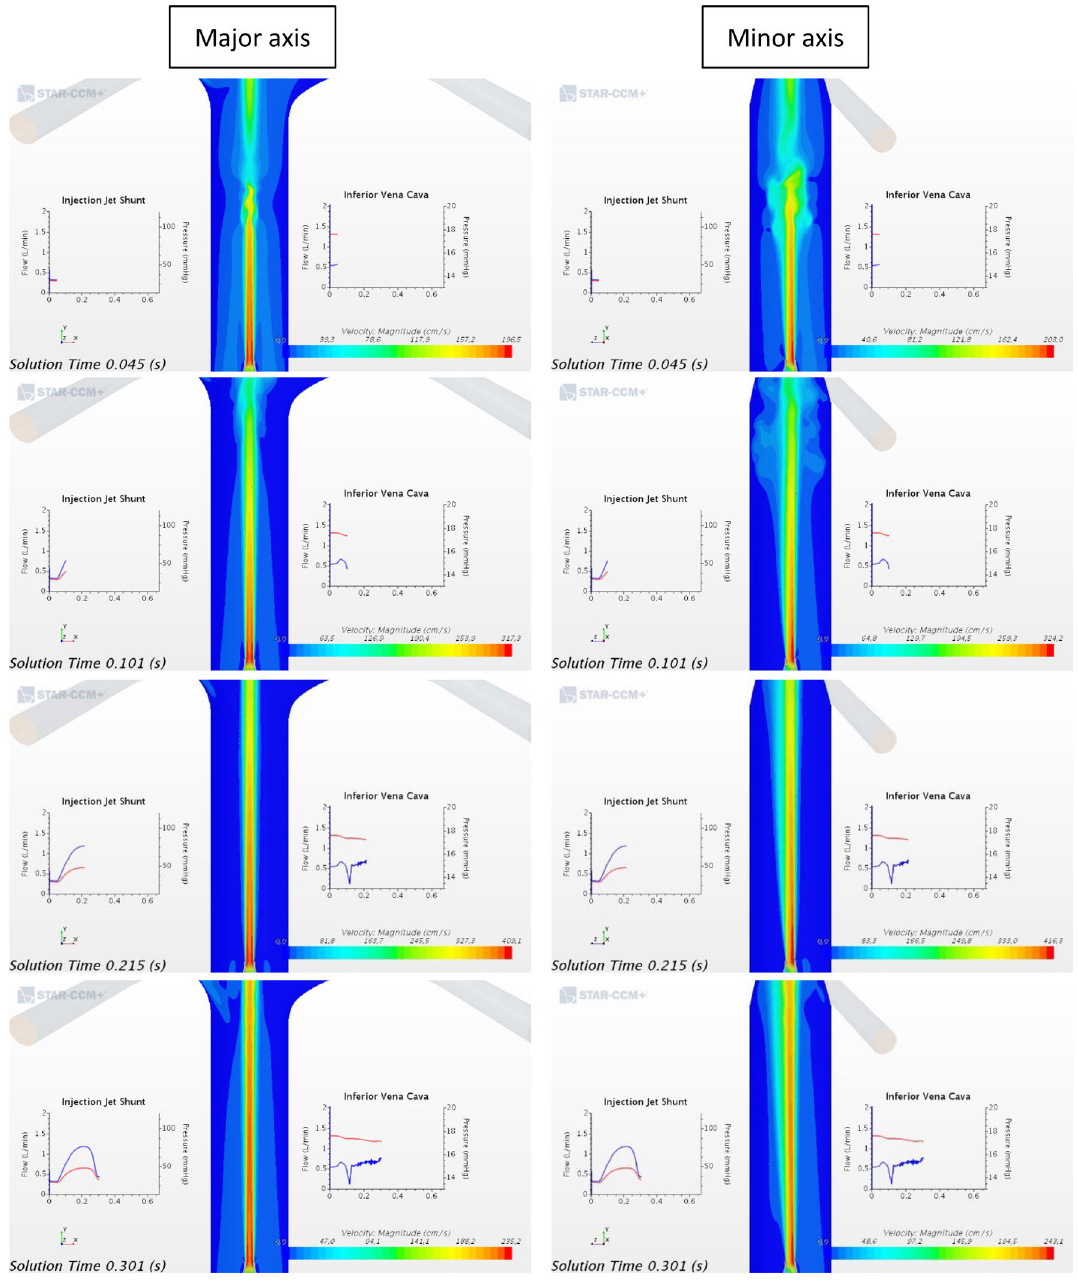
Figure 4. Velocity magnitude contour plots for a 2 mm circular IJS nozzle, 7 cm IJS-TCPC distance and 7 mm fenestration along major and minor axis across a single heart cycle. The x–y plots display pressure (blue) and volume flow rate (red) sampled in the IJS shunt and the